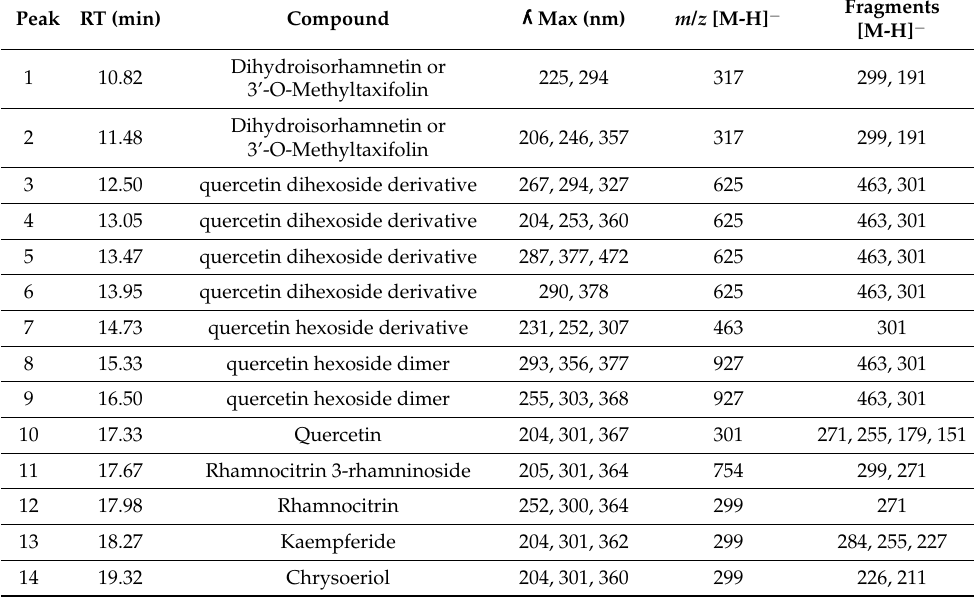
compounds, while in the bulb extract chromatogram, peaks 3, 4, and 5 are missing.